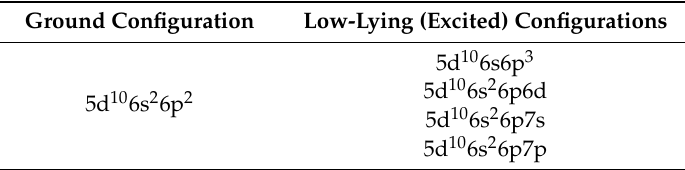
Table 1. Ground and lowly lying electron configurations of Bi + included in the Cowan code photoabsorption calculations.